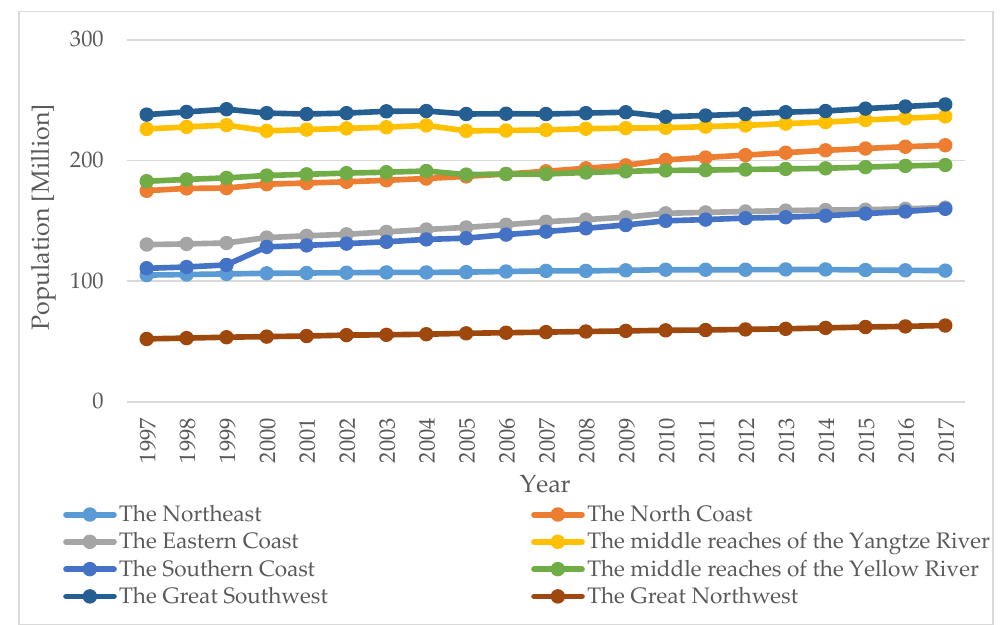
Figure 7. Regional population sizes of China from 1997 to 2017.